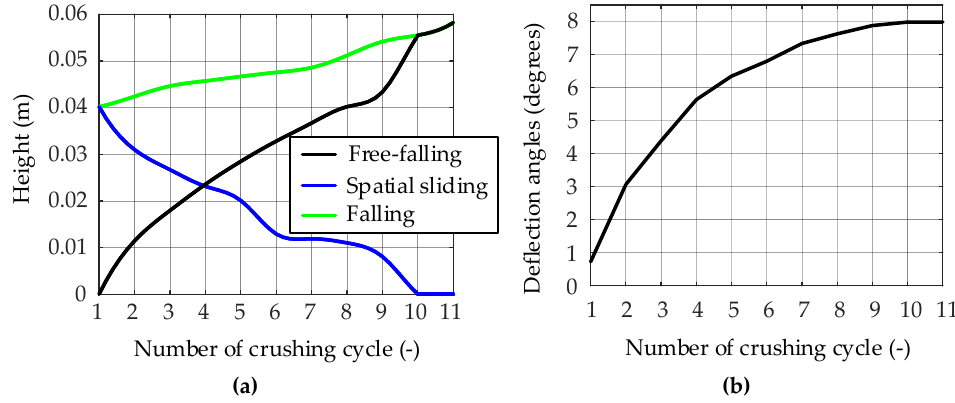
Figure 14. The motion characteristics of broken particles in each crushing cycles. ( a )The change in the height of broken particles with different motion characteristics during each crushing cycle.